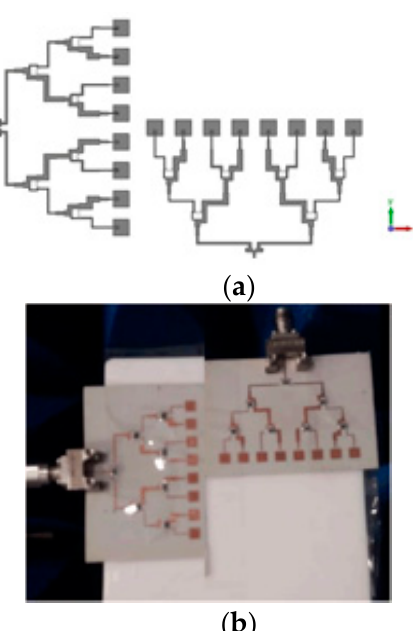
Figure 5. Linear antenna array.